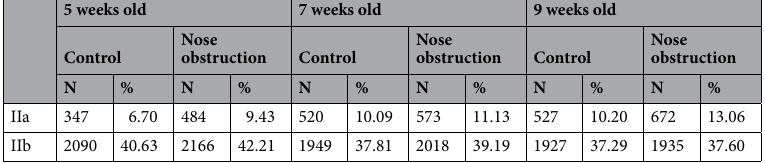
Table 3. Number of IIa and IIb fast genioglossus muscle fibers and percentage. Data presented as total number (N), and percentage (%). IIa fast-twitch IIa type muscle fiber, IIb fast-twitch IIb type muscle fiber.